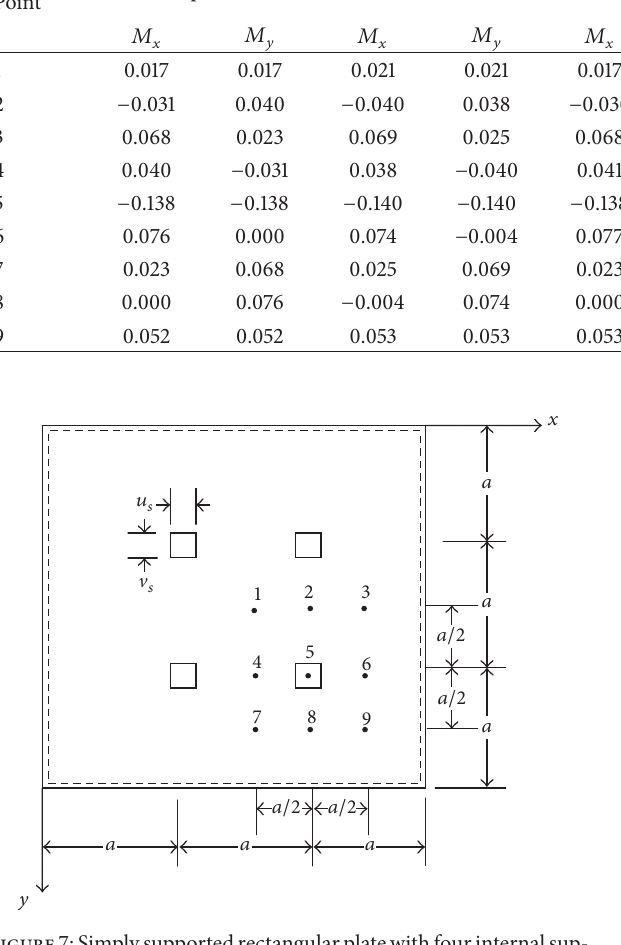
Figure7:Simplysupportedrectangularplatewithfourinternalsup- ports.